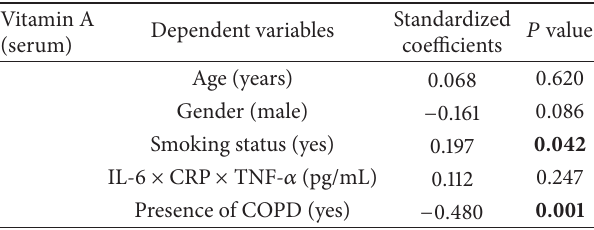
Table 4: Robust multiple linear regression to identify factors asso- ciated with vitamin A